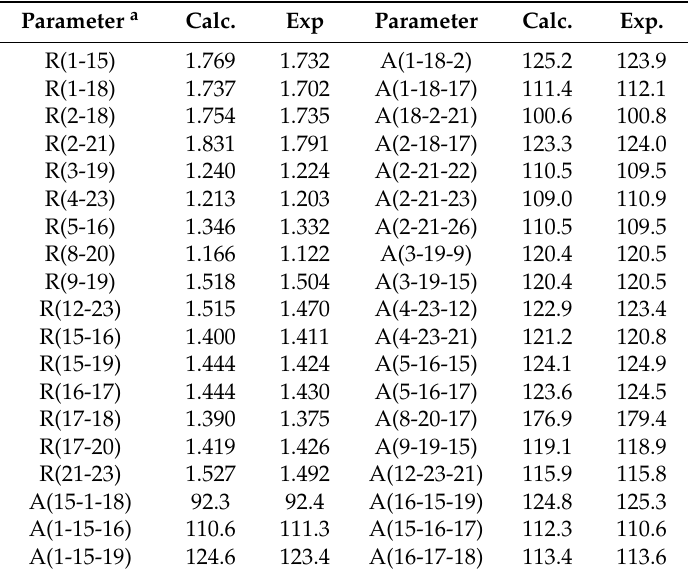
a Atoms’ numbering according to Figure 3.